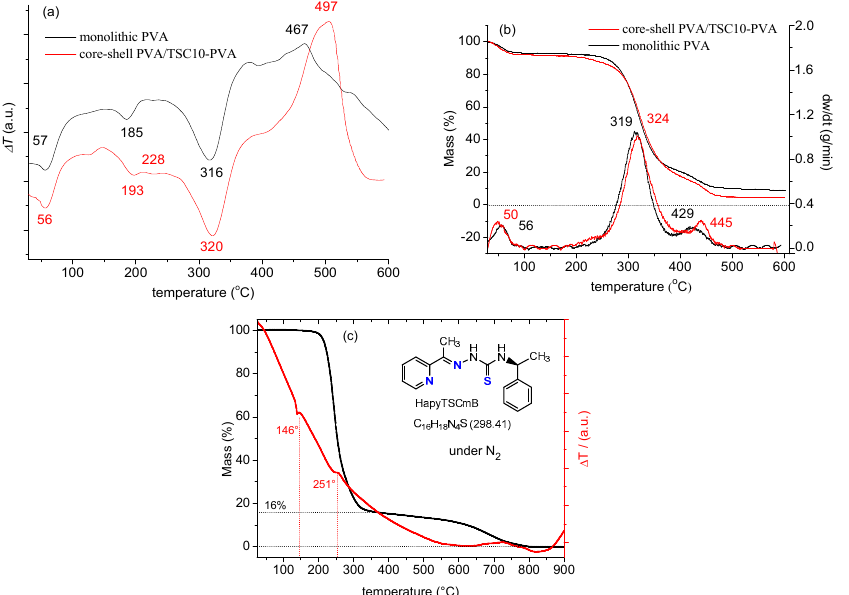
Figure 3. Thermograms of the monolithic PVA and the core–shell PVA/TSC10-PVA fiber mats ( a ) differential thermal analysis (DTA), ( b ) thermogravimetry/derivative thermogravimetry (TG/DTG); ( c ) TG/DTA of pure TSC.